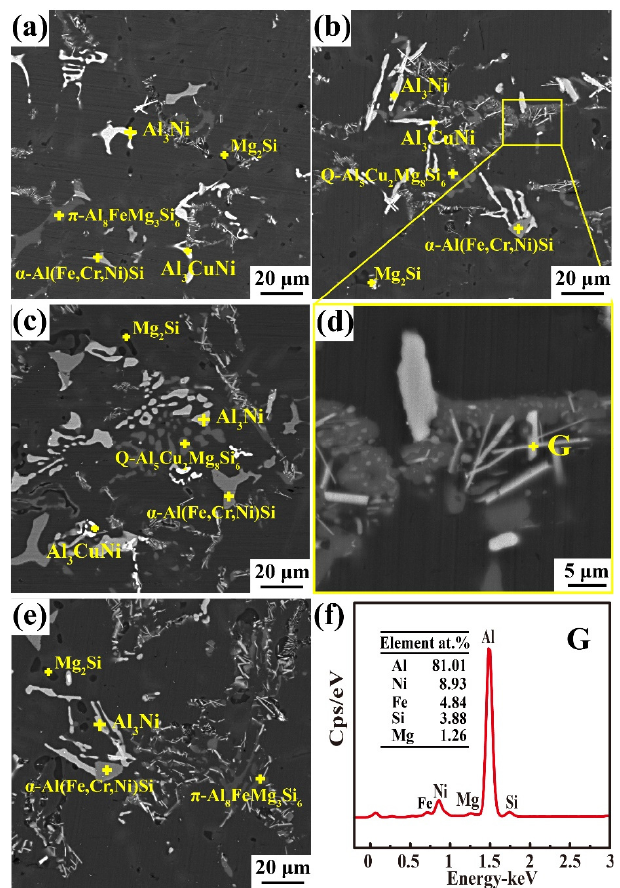
Figure 9. SEM images of Al-Si-Cu-Mg-Ni alloy under different solid solution conditions: ( a ) 500 °C for 2 h and 540 °C for 2 h, ( b ) 500 °C for 2 h and 540 °C for 4 h, ( c ) 500 °C for 2 h and 540 °C for 8 h, ( d ) enlargement of the boxed area in ( b ), ( e ) 500 °C for 2 h and 540 °C for 10 h, ( f ) EDS analysis of Point G in ( d ).